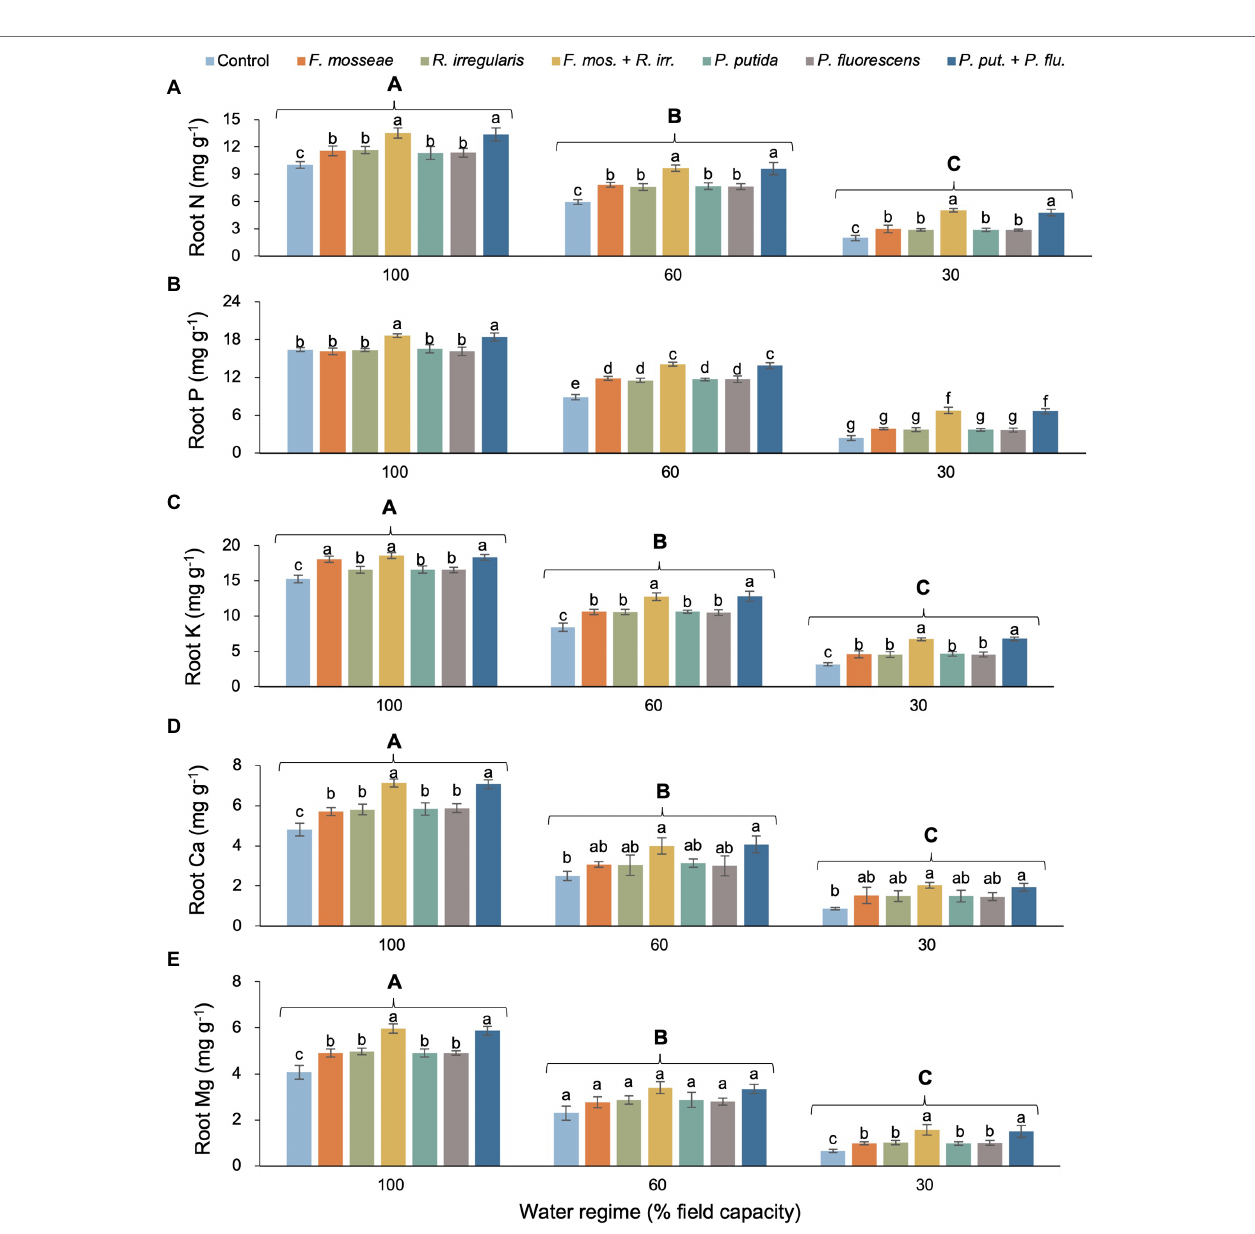
FIGURE 4 | Effect of water regime and soil microbial inoculation on the root N (A) , P (B) , K (C) , Ca (D) , and Mg (E) of M. communis seedlings (expressed on a dry weight basis). A significant water regime × inoculation treatment interaction only occurred for root P, while for all other root nutrients only the main effects were statistically significant. Accordingly, different lower-case letters indicate significant differences between microbial inoculation treatments across levels of water deficit for root P but only within water regimes in the remaining root nutrients (Duncan’s new multiple range test, α = 0.05). Different upper-case letters indicate significant differences between water regimes (Duncan’s new multiple range test, α =